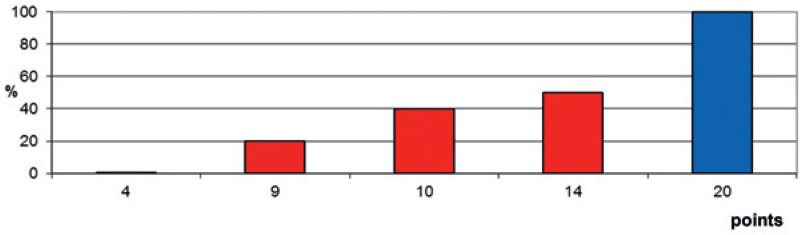
The 6-months survival rates of the prognostic scores (4, 9, 10, 14 or 20 points).